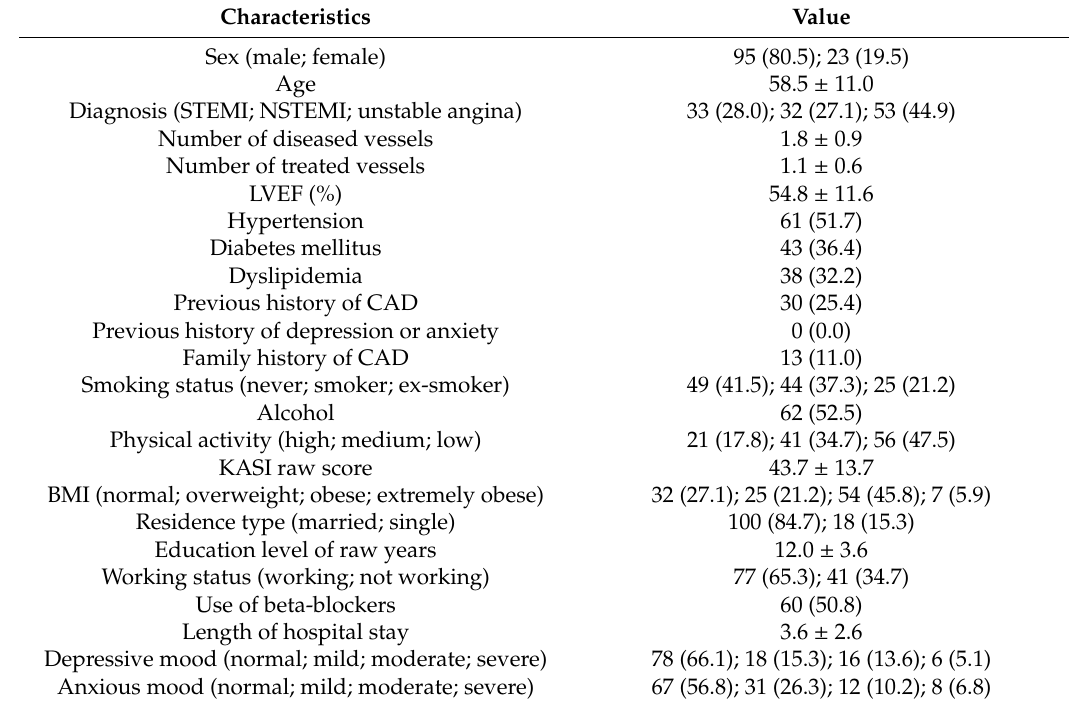
Table 1. Baseline characteristics of the